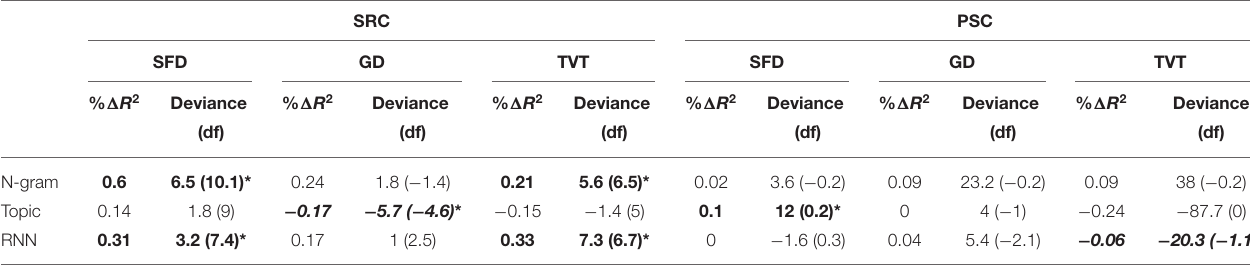
TABLE 7 | χ 2 tests whether the respective language model performed better than